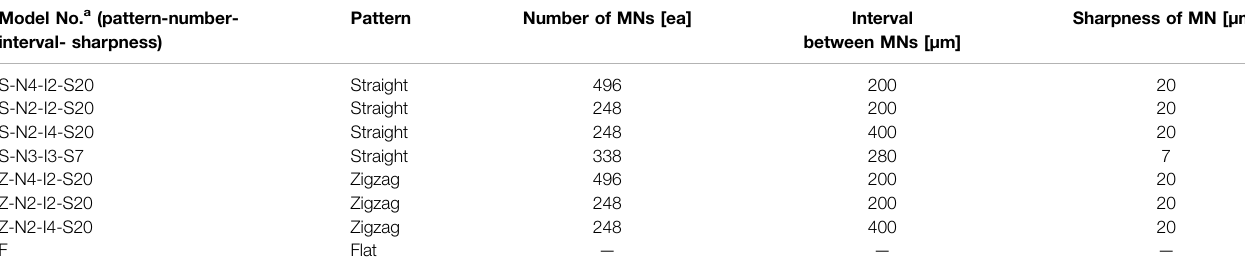
TABLE 1 | Information on eight variations of microneedles attached to a swab head. Model No. a (pattern-number- interval-